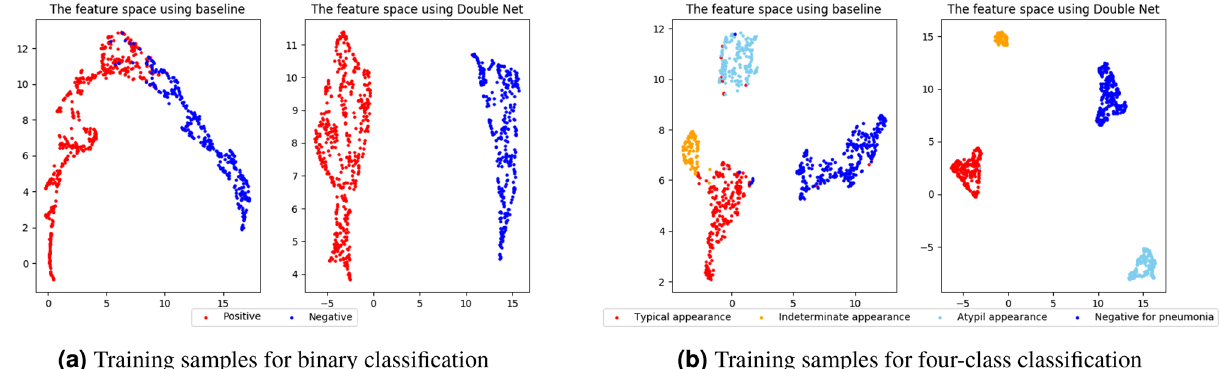
Figure 4. Visualization results of features at last convolutional layer of ResNet18 when we used the training samples. We compressed the features into two dimensions using UMAP 54 for ( a ) binary classification and ( b ) four-class classification.